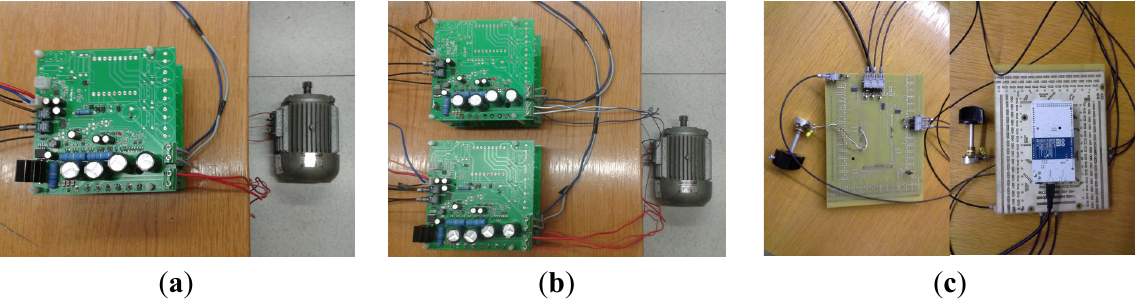
Figure 6. Experimental setup. ( a ) Single-2L inverter feeding the star-connected three-phase induction motor; ( b ) dual-2L inverter feeding the same motor in the open-end windings configuration; ( c ) microcontroller board with optic link fibers (up and bottom